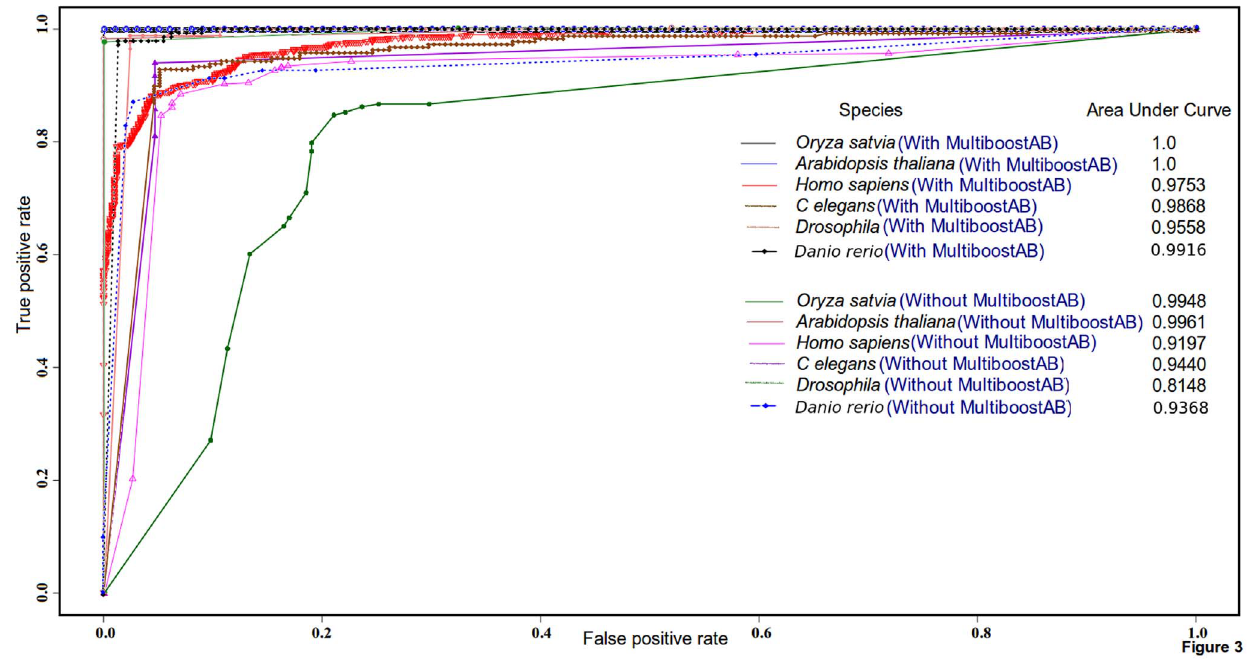
Figure 3. ROC plot with area under the curve values for all the six target species considered in this study. The plot suggests better and stable performance of the classifiers with multiboosting.